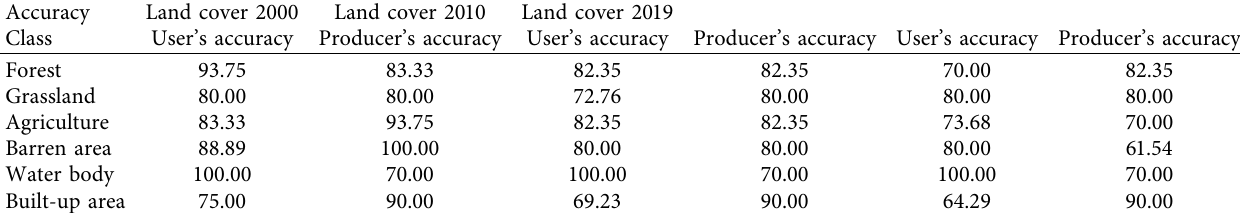
Figure 2: Land cover change in different periods. (a) Land cover 2000. (b) Land cover 2010. (c) Land cover 2019. Table 2: Accuracy assessment of different land cover classes.